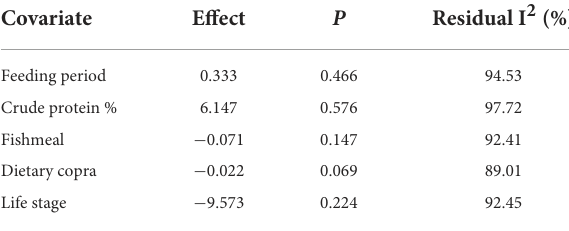
TABLE 5 Meta-regression for